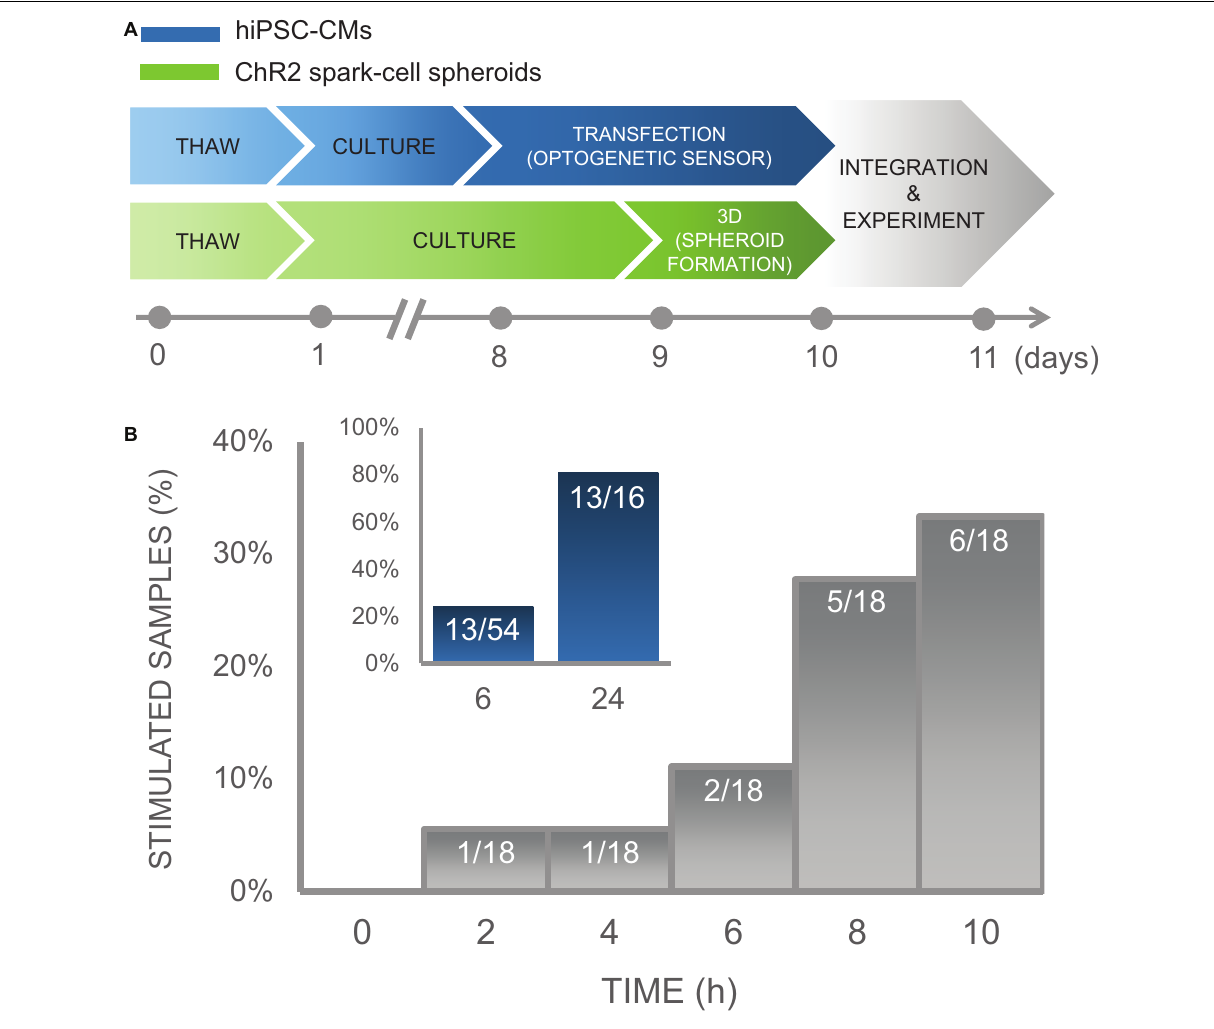
GAPDH (ab181602, Abcam). Changes of Cx43 protein levels were presented as normalized to